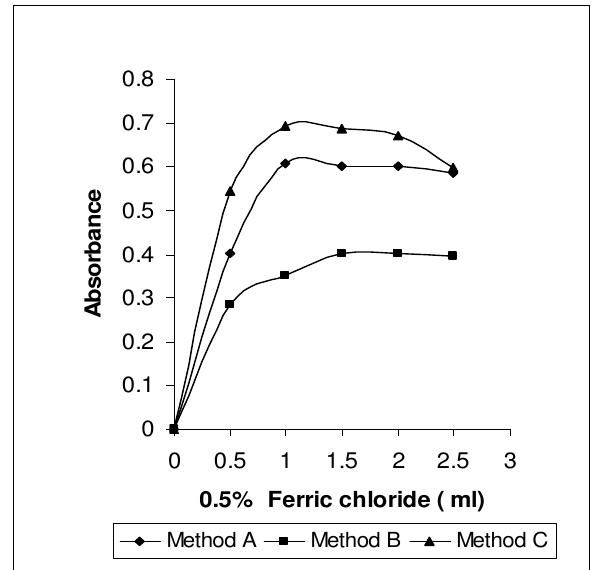
Figure 2. Effect of Ferric chloride concentration (200 m g mL -1 drug + 1 mL of o -phenanthroline/2, 2’ bipyridyl/ potassium ferricyanide)